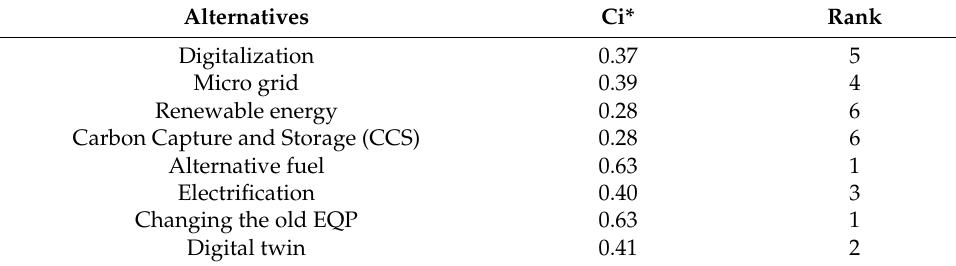
Access to skilled workers Table 5. Top alternatives in the technology and innovation criterion. Alternatives